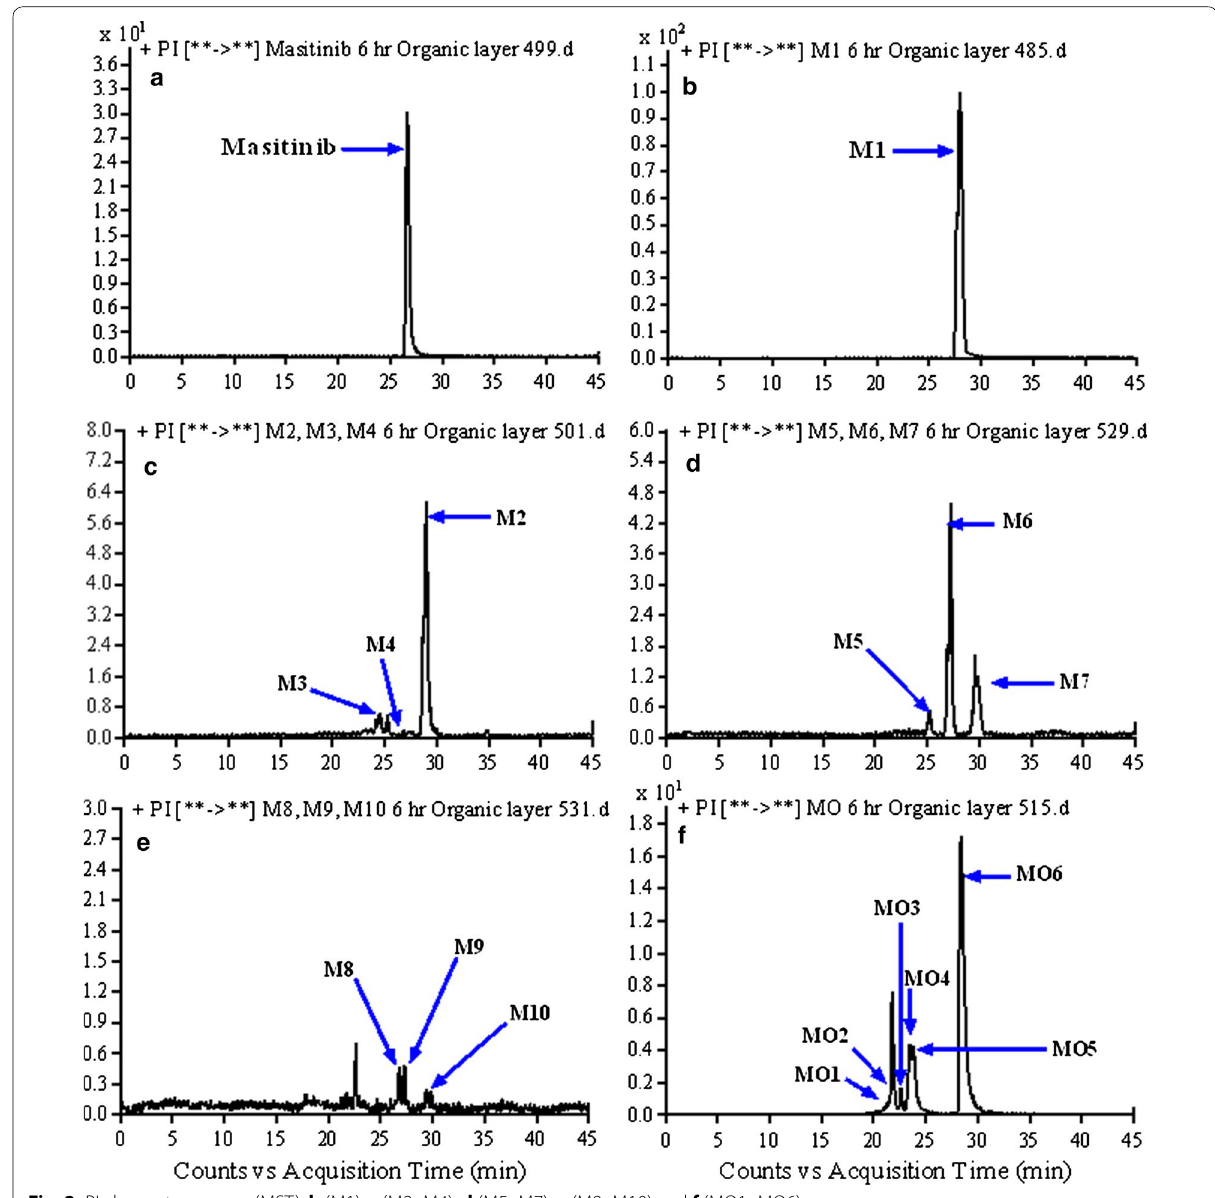
Fig. 2 PI chromatograms: a (MST), b (M1), c (M2–M4), d (M5–M7), e (M8–M10) and f